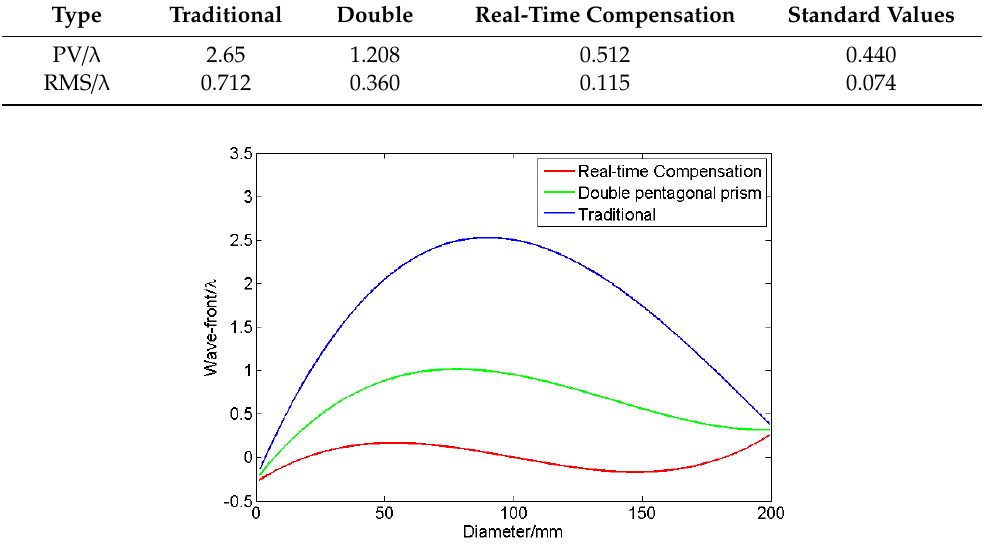
Figure 5. Fitting results with different methods.